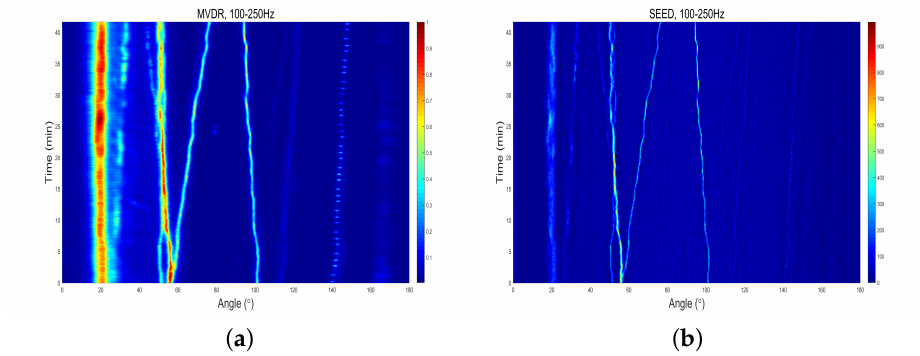
Figure 10. Sea-trial experiments. ( a ) Original MVDR1; ( b ) SEED.